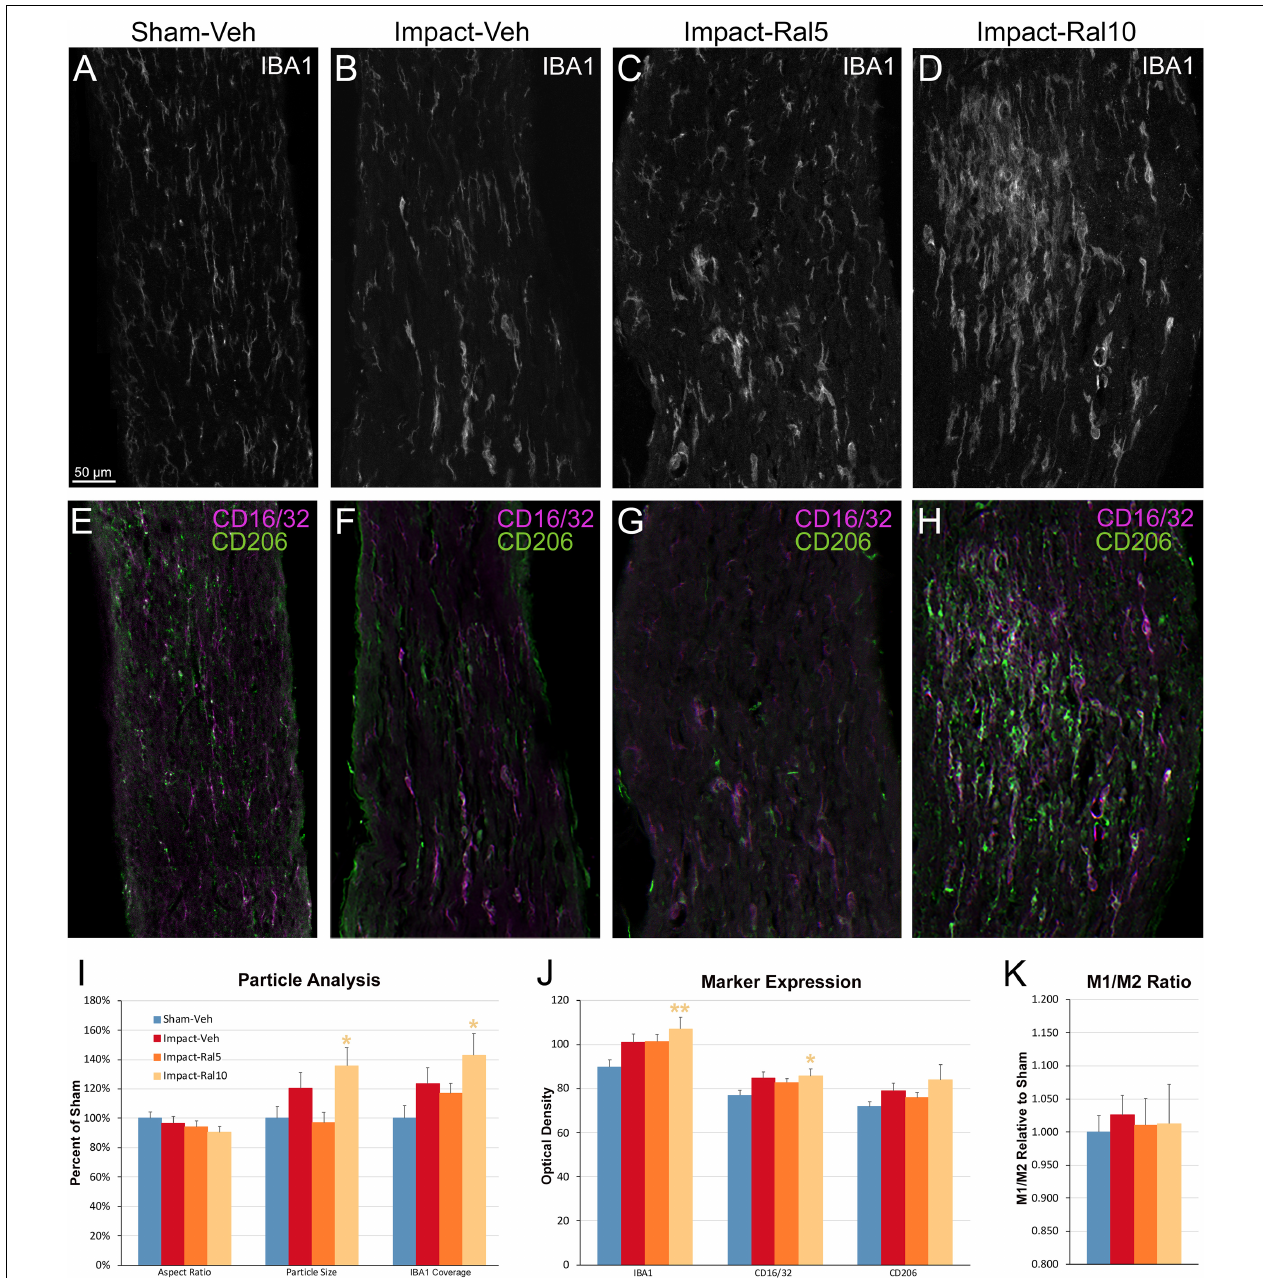
FIGURE 7 | Microglia in the optic nerve 3 days after impact TBI. (A–F) Confocal images of sections immunostained for IBA1 to visualize microglia, for the M1 marker, CD16/32, and for the M2 marker, CD206. The upper panels show IBA1 immunolabeling (white), while the matching lower panels show the merge for CD16/32 (magenta) and CD206 (green). (A,E) Microglia in the sham-vehicle mouse have small cell bodies, have thin processes, and are lightly labeled. (B,F) Microglia in the impact-vehicle mouse are larger and more intensely labeled. (C,G) Microglia in impact-ral5 mice largely resemble those in impact-vehicle mice. (D,H) Microglia in impact-ral10 mice are larger, rounder in shape, and more intensely labeled than microglia in the impact-vehicle mice. The green CD206 immunolabeling in (H) is more predominant than in (F) , reflecting the lower M1/M2 ratio for impact-ral10 mice. The scale bar in (A) applies to (A–H) . (I–K) Quantification of IBA1, CD16/32, and CD206 immunolabeling. Optic nerve area occupied by microglia, size, and roundedness of IBA1+ particles, expression of IBA1, CD16/32, and CD206, and M1/M2 ratio were all increased in impact-vehicle mice. Raloxifene at 5 mg/ml reduced CD16/32 and CD206 expression, M1/M2 ratio, optic nerve area occupied by microglia, and the size and roundedness of IBA1+ particles relative to impact-vehicle mice, but not IBA1 expression. Microglial area and size and roundedness of IBA1+ particles were greater for impact-ral10 mice than for impact-vehicle mice, IBA1 and CD206 were increased above impact-vehicle levels, but CD16/32 to a lesser extent, resulting in a lower M1/M2 ratio. Numbers of optic nerves analyzed: 10 sham-vehicle mice, 11 impact-vehicle mice, 12 impact-ral5 mice, and 15 impact-ral10 mice. Yellow asterisks indicate significant differences between the impact-ral10 mice and the sham-vehicle mice; * p < 0.05, ** p < 0.01.